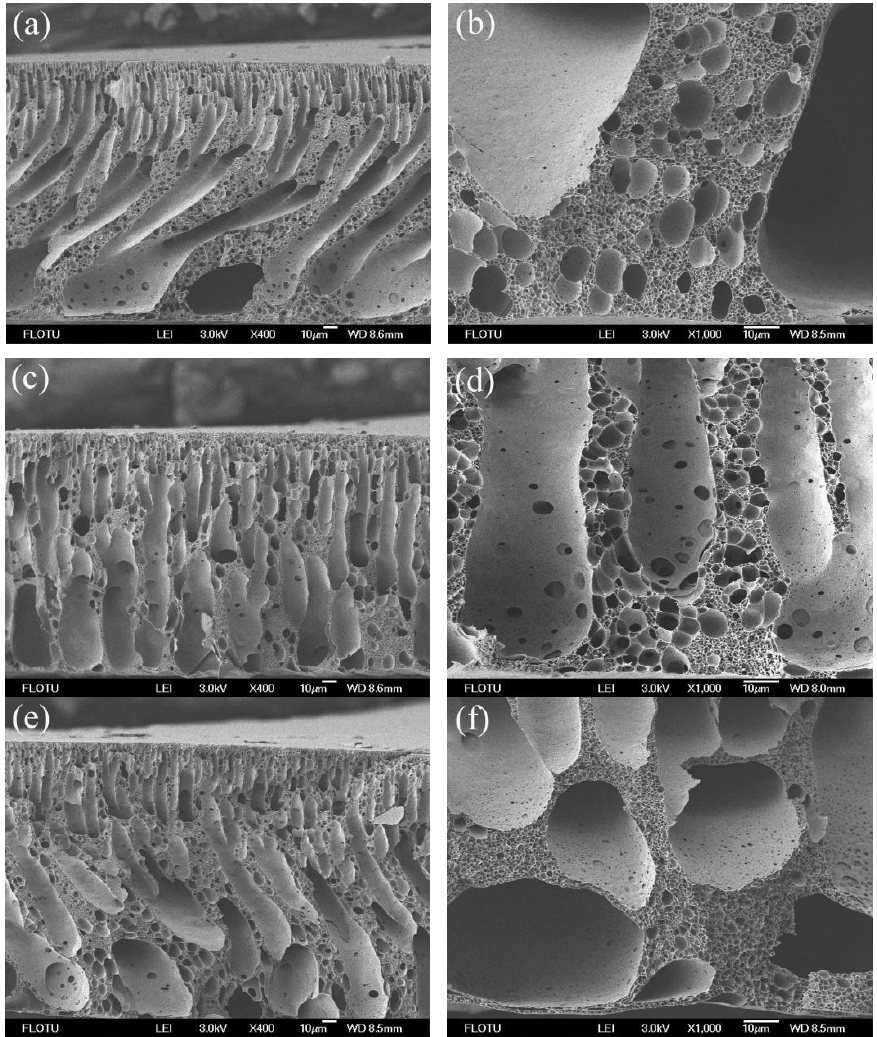
Figure 5. SEM photomicrographs of cross-section of PPSU UF membranes prepared by single and compound additives with PVP as a polymeric pore-forming agent: ( a , b ) PPSU2; ( c , d ) PPSU3; ( e , f ) PPSU4.